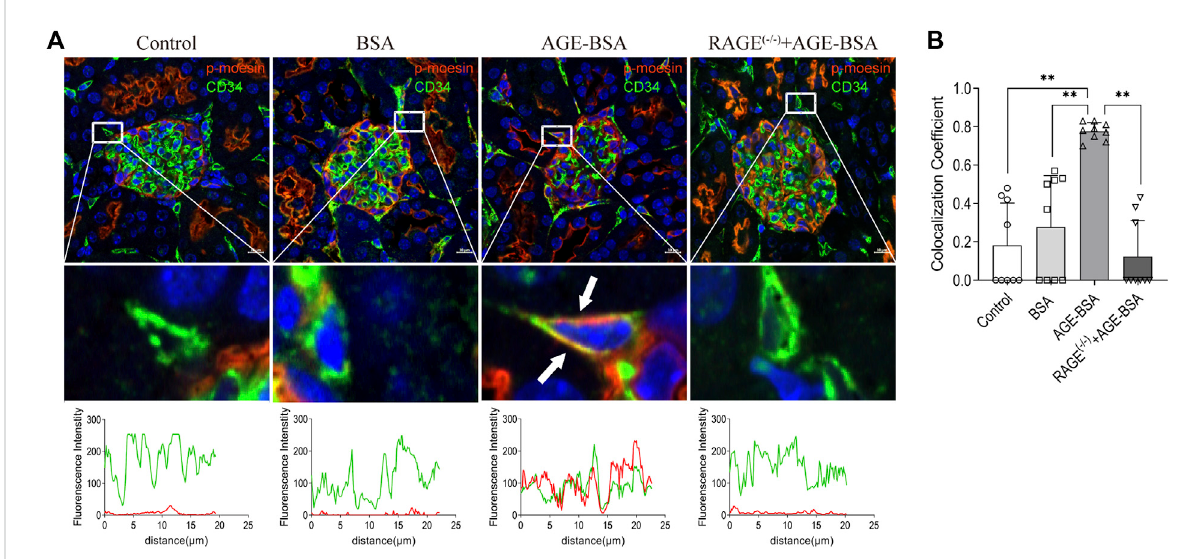
FIGURE 7 Colocalization of phospho-moesin with CD34 in renal glomeruli under AGE treatment. (A) Phospho-moesin (red) and CD34 (green) were presented in renal glomeruli by immuno fl uorescence assay with TSA (tyramide signal ampli fi cation) technology. DAPI (blue) was used to stain nuclei (upperpanel).Scalebar=10 μ m.Periglomerularvessel(CD34 + )wasselectedfordetailedobservation(middlepanel)ofcolocalizationwithphospho- moesin (white arrows). The green and red fl uorescence density and localized distance were measured (lower panel). (B) Quanti fi cation of the fraction of phospho-moesin colocalizing with CD34 in different groups, expressed as the Mander ’ s overlap colocalization coef fi cient. n = 9 (three different fi elds analyzed from one sample from three different animals), ** p <